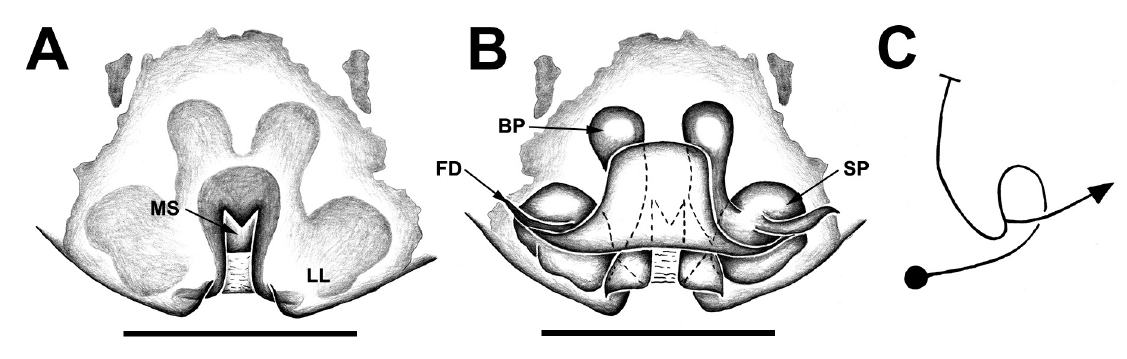
Fig. 7. Cuiambuca borborema sp. nov., holotype, ♀ (IBSP 60011). A . Epigyne, ventral view. B . Vulva, dorsal view. C . Schematic course of internal duct system. Abbreviations: BP = blind ending projection; FD = fertilization duct; LL = lateral lobe; MAB = muscle attachment bands; MS = median septum; SP = spermathecae. Scale bars = 0.5